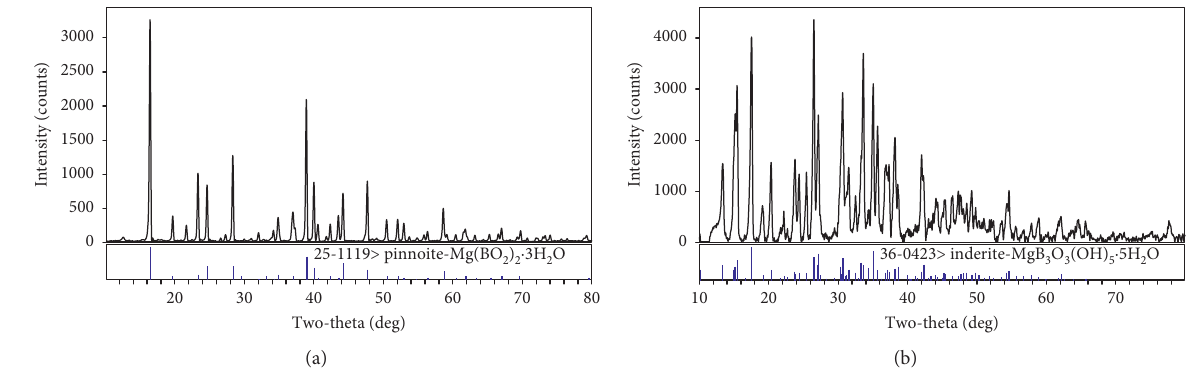
Figure 1: The X-ray diffraction patterns of pinnoite (a) and inderite (b).